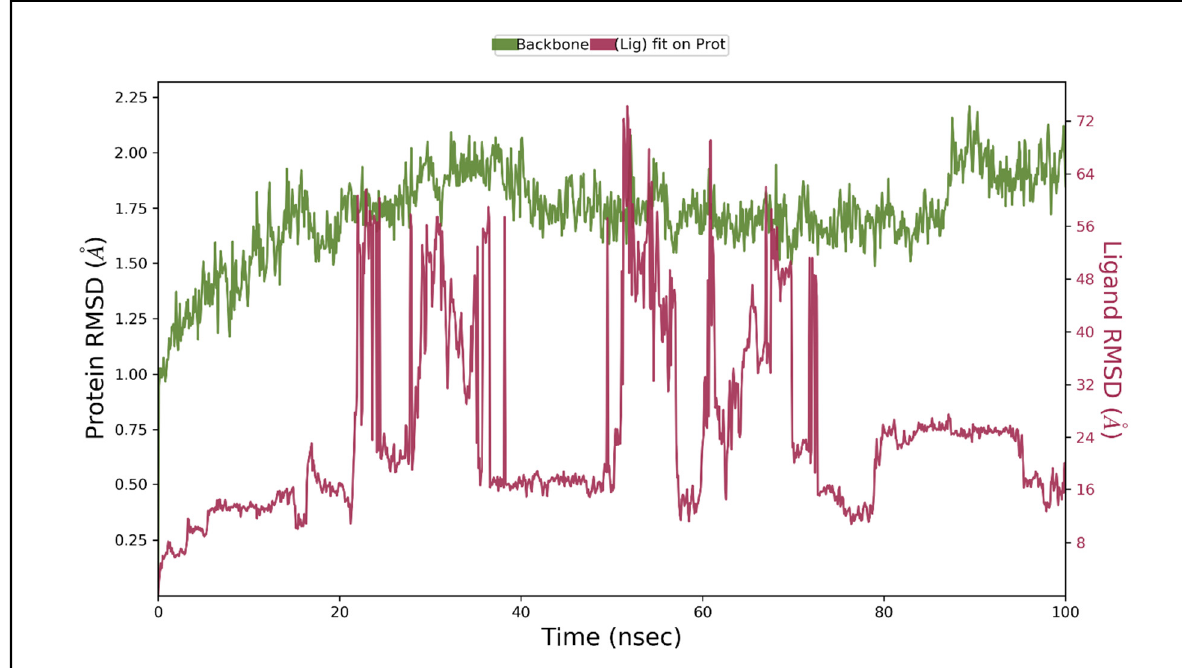
Figure 9. Root means square deviation (RMSD) of protein and ligand after the initial RMSD values were stabilized. This plot shows RMSD values for protein on the left Y-axis, whereas for ligand, these values are indicated on the right Y-axis. The RMSD graph for the backbone is shown in green, and for theligand fit on protein in red.